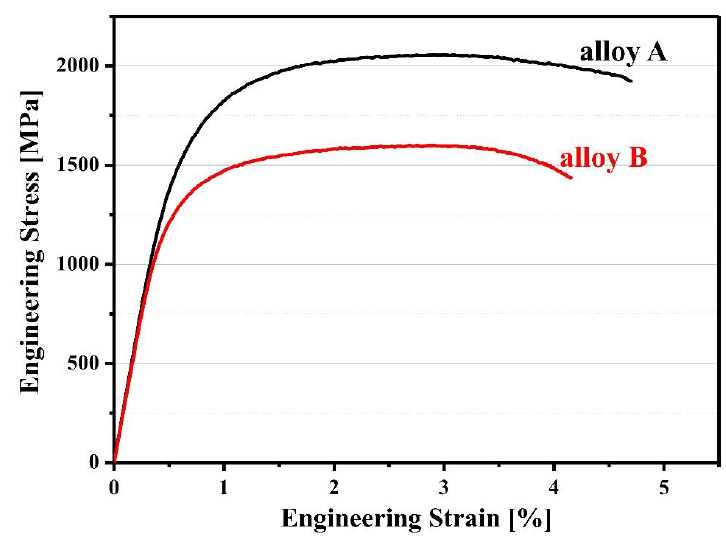
Figure 10. Comparison of tensile curves of direct-quenched steels (alloys A and B) Table 2. Representative tensile properties of alloys A and B.